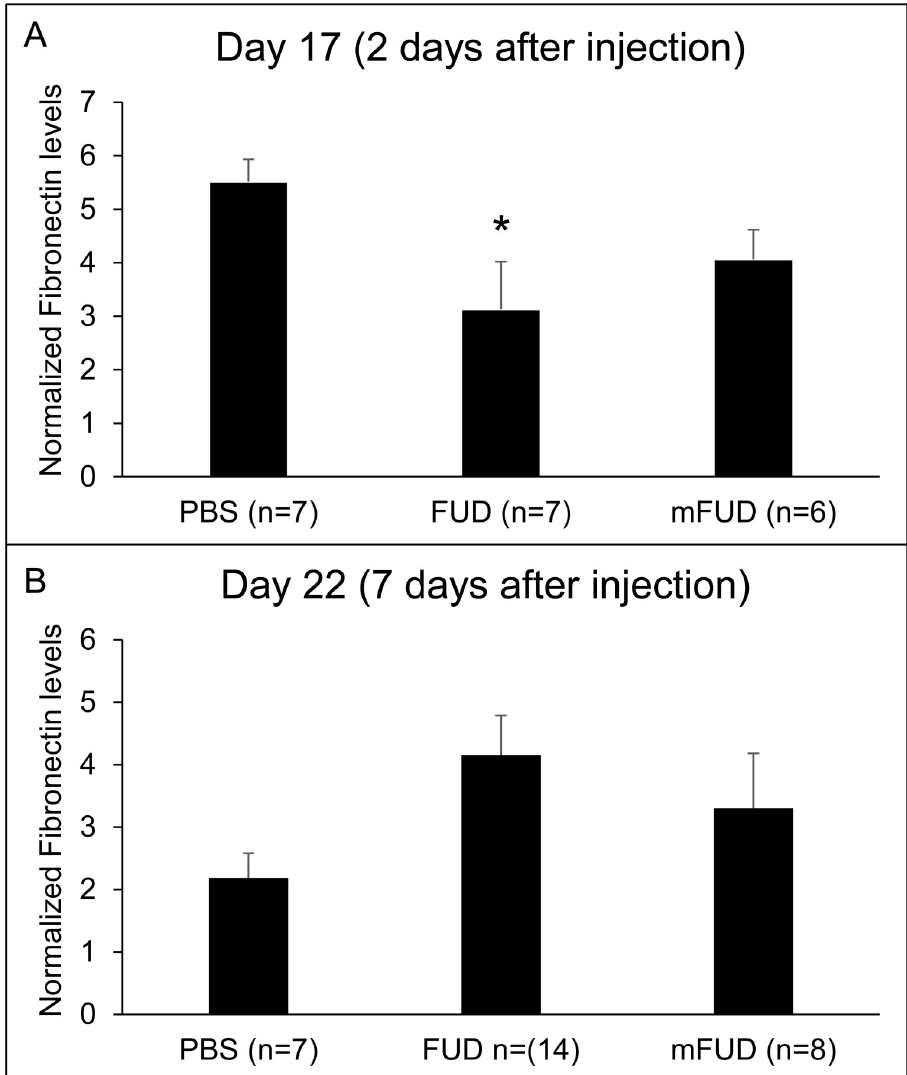
Fig 5. FUD lowered fibronectin levels in the TGF β 2 transduced mouse eyes. (A) Western blot densitometry analyses of lysates from TGF β 2 transgene expressing mice treated for 2 days (Day 17) with PBS, FUD or mFUD probed with anti-fibronectin sera. The same western blots were then probed with anti-SDHA antibody as a housekeeping gene. The density of the fibronectin bands were normalized to SDHA for each sample. Data are the mean ± SEM of the normalized fibronectin bands for each treatment group. Fibronectin levels in TGF β 2 + PBS treated eyes were significantly different from levels in TGF β 2 + FUD treated eyes ( � p < 0.05). Statistical analysis was performed using an unpaired Student t-test. (B) Western blot densitometry analyses of lysates, probed with anti-fibronectin sera, from TGF β 2 transduced mice treated for 7 days with PBS, FUD or mFUD. The same western blots were then probed with anti-SDHA antibody as a housekeeping gene. The density of the fibronectin bands was normalized to SDHA for each sample. Data are the mean ± SEM of the normalized fibronectin bands for each treatment group. There were no statistically significant differences between the data points. Statistical analysis was performed using an unpaired Student t-test.